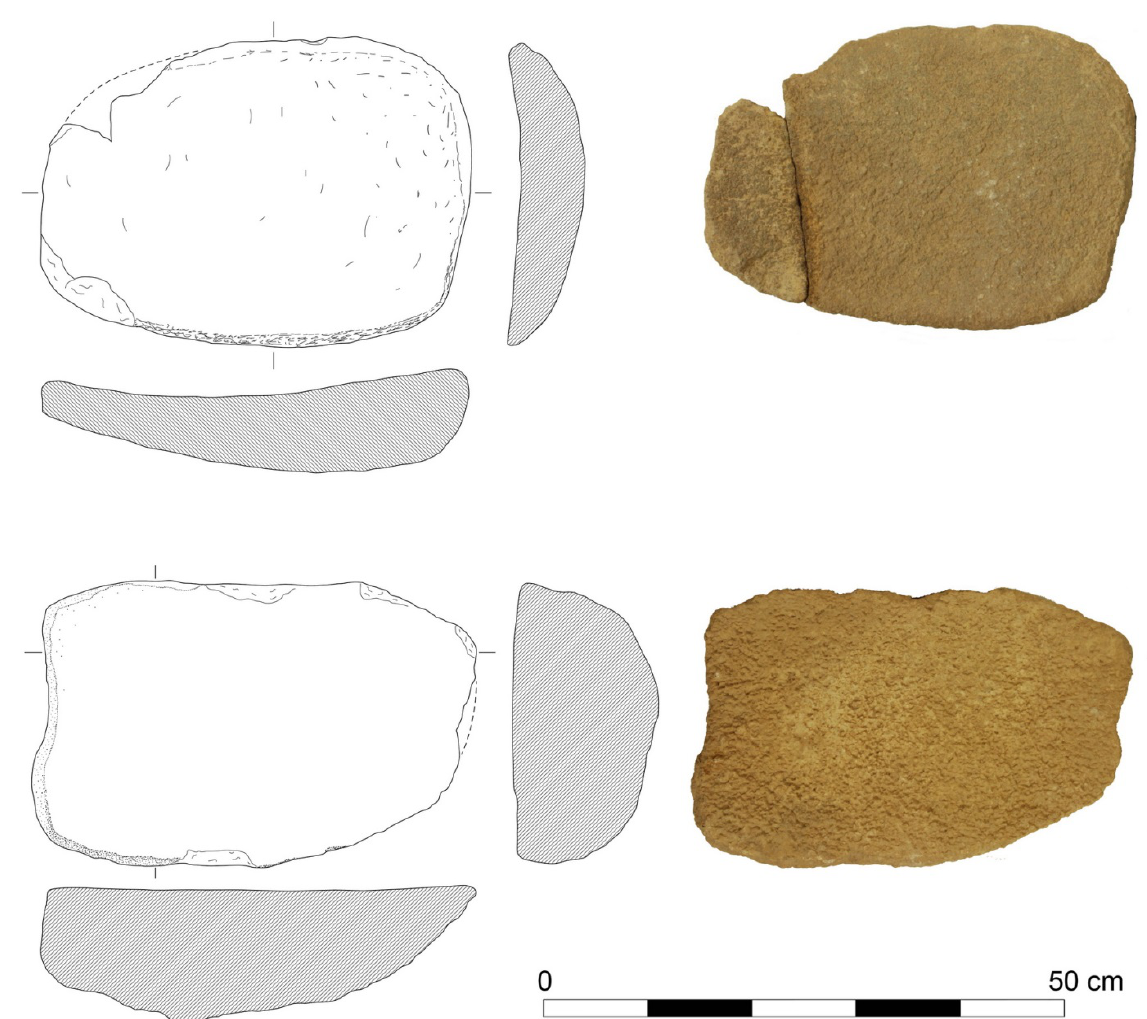
Figure 6. A large sunken saddle quern and a large concave grinding slab found in the lower phase of Unit 6, Fazael